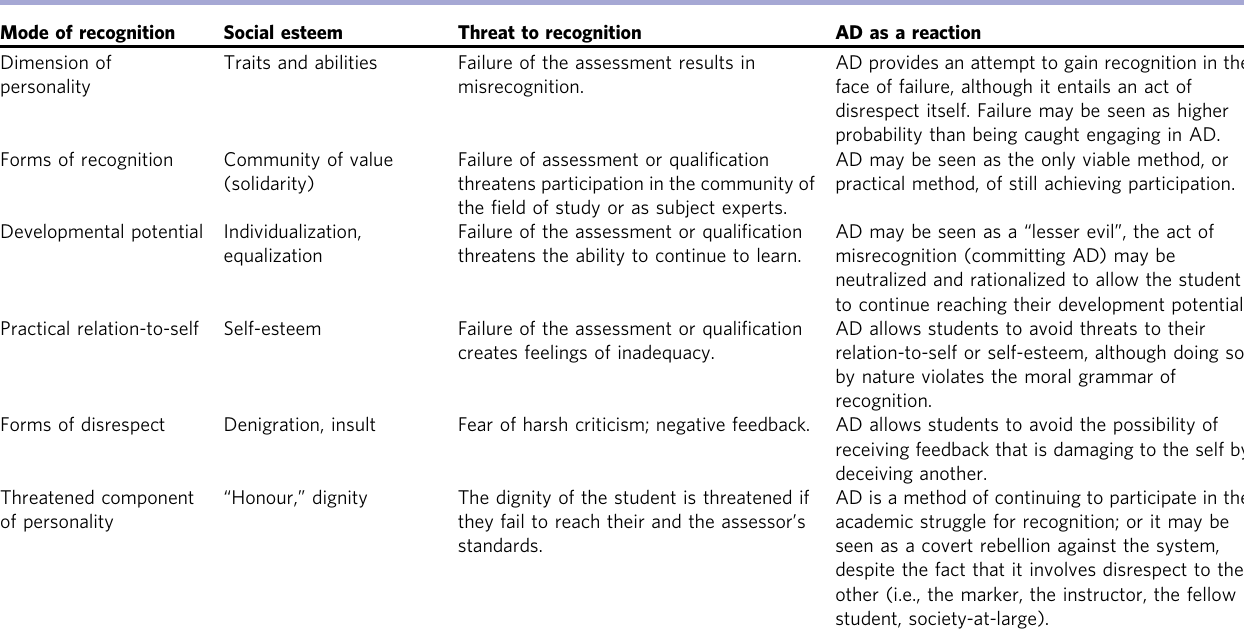
Table 2 Application to acts of academic